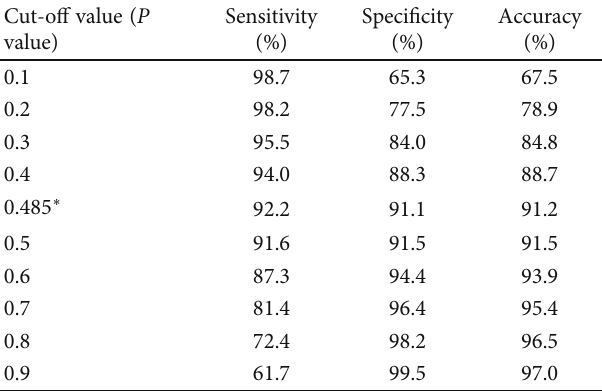
Table 4: The ability of classi fi cation for each cut-o ff